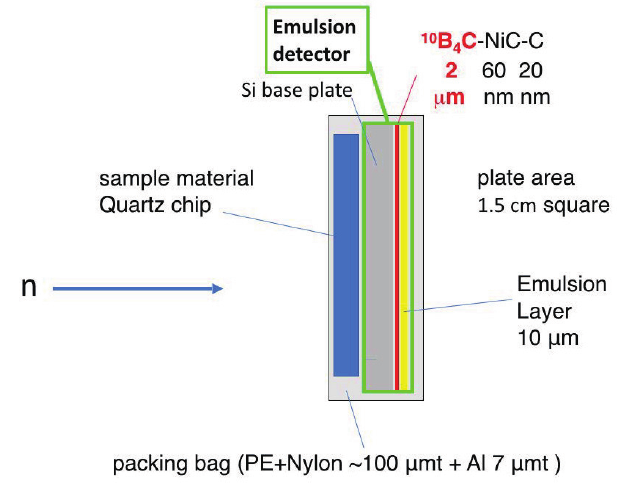
Figure 2. Structure of the neutron emulsion. The emulsion and sample material are vacuum-packed in a bag consisting of polyethylene, nylon, and